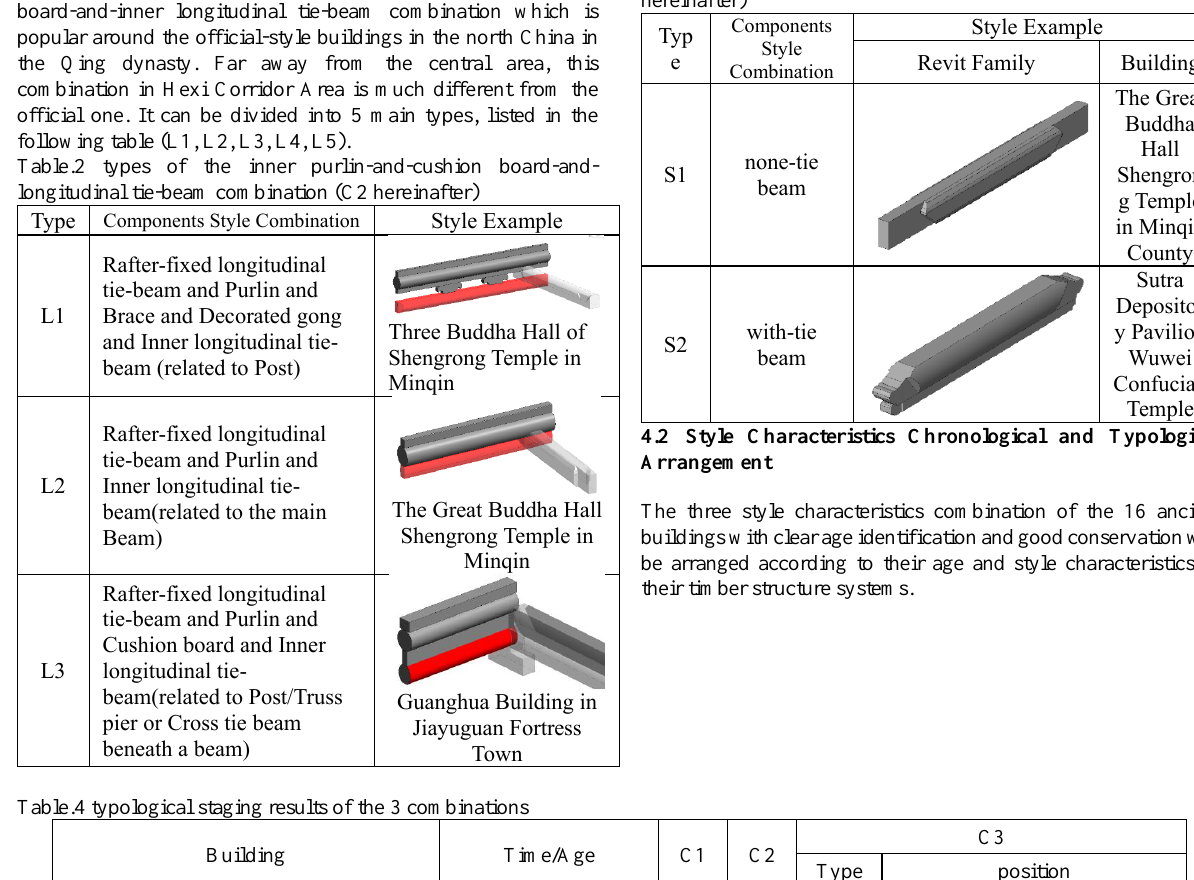
Table.3 types of the beam-and-tie beam combination (C3